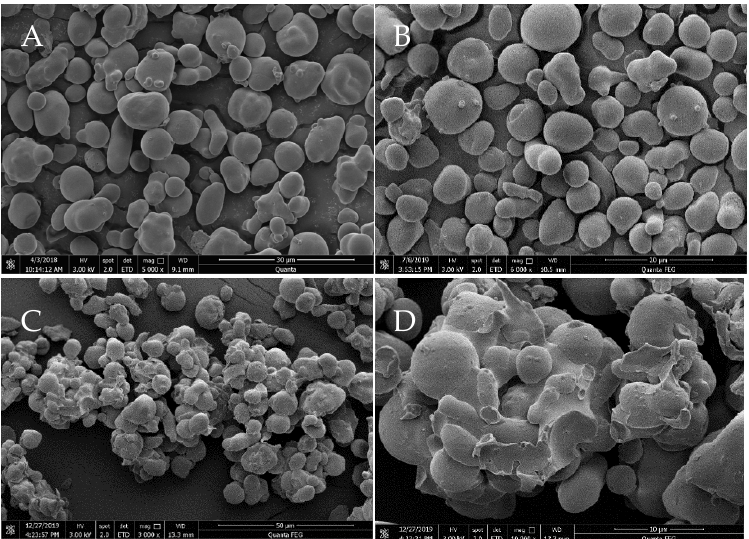
Figure 1. Scanning electron micrographs of the HACS (( A ): 5000× magnification), hydro-micro-HACS (( B ): 6000× magnification), and the composite (( C , D ): 3000× and 10,000× magnification).